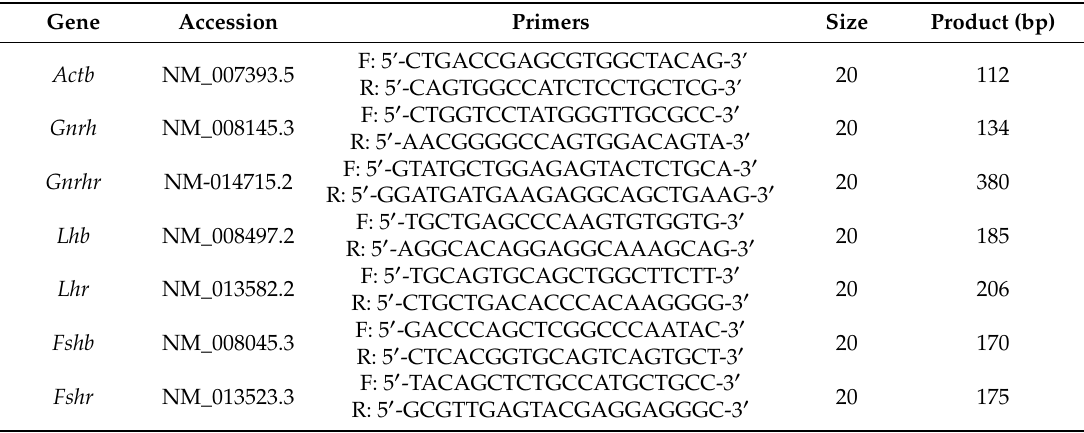
Table 1. List of primers for reproductive system genes